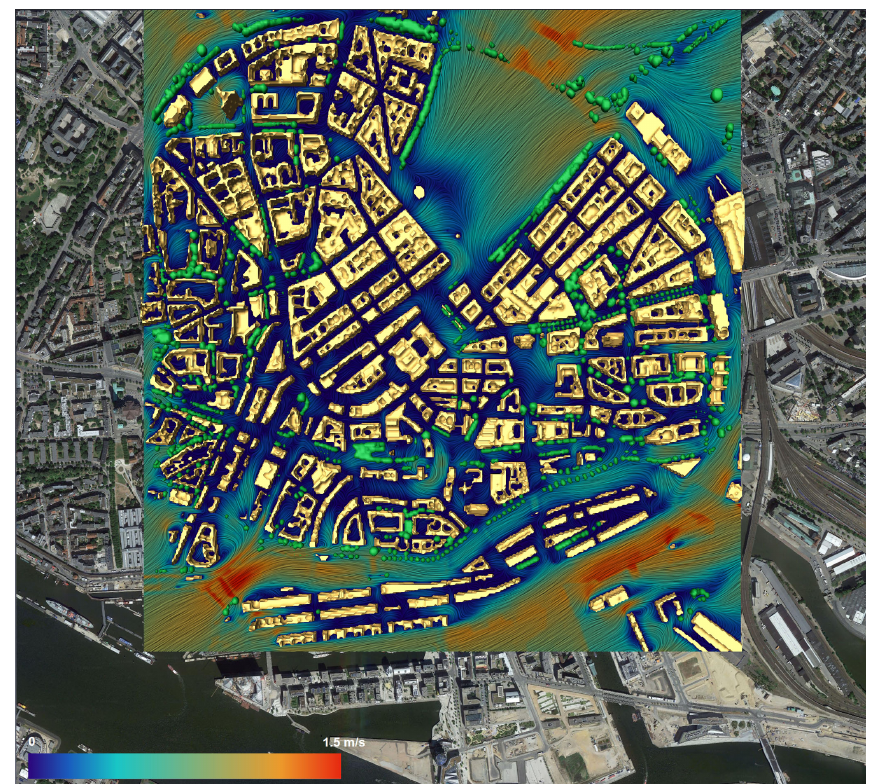
Figure 6. Snapshot of the wind speed in the city center of Hamburg (Germany) from a simulation that includes the effect of trees. The simulated domain (2000m × 2000m) contains about 2800 trees with 130 different species. Buildings and trees are displayed in shades of yellow and green, respectively. The animation setup was kindly provided by Niklas Röber at DKRZ. The copyright for the underlying satellite image is held by GeoBasis-DE/BKG (©2009),